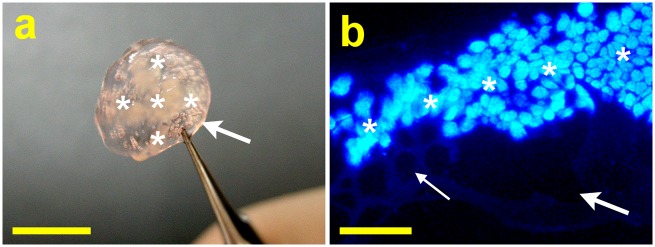
Fabrication of HA-CEC sheet constructs using thermo-responsive culture supports and porous delivery carriers.(a) Picture of bioengineered cell sheet graft (asterisk) attached to the porous hydrogel carrier (arrow) from OFHA group. Scale bars: 5 mm. (b) Light micrograph of cross-section of the construct stained with Hoechst 33258. Large arrow: larger pore on the interior of the carrier; Fine arrow: smaller pore on the surface of the carrier; Asterisk: cell sheet. Scale bars: 200 μm.